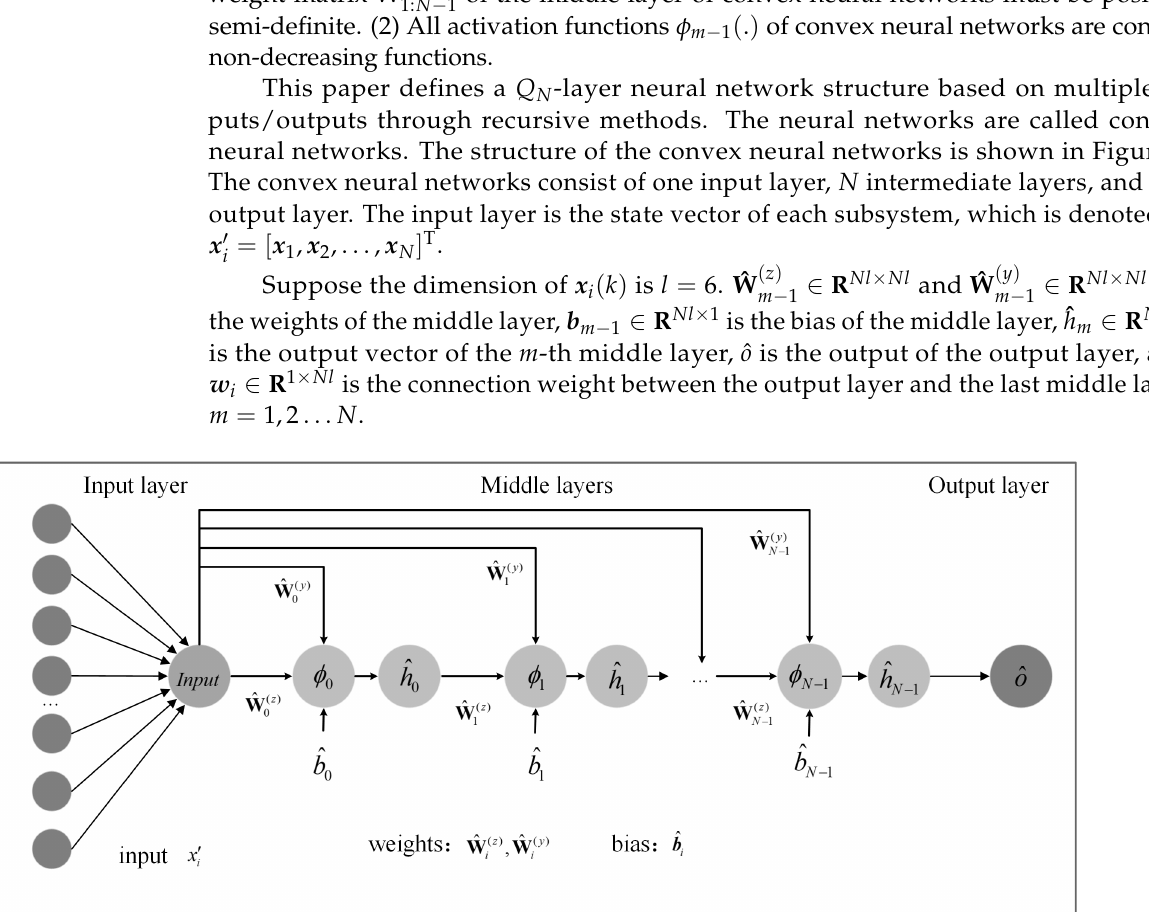
Figure 3. The structure of the convex neural